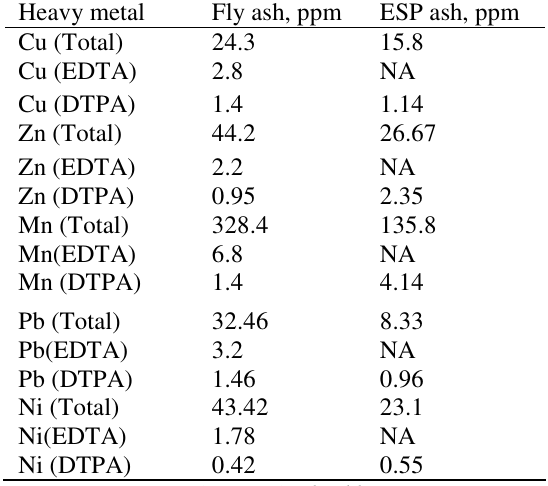
Table 3 . Heavy metal concentration in fly ash and ESP